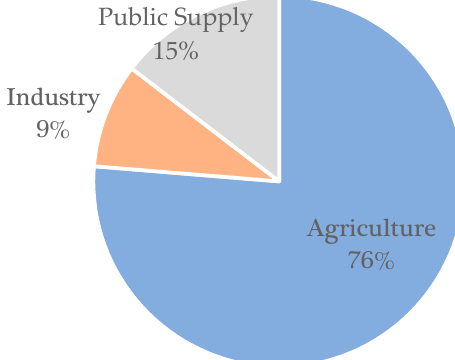
Figure 1. Percentage of Water Use in Agriculture, Industry and Public Supply, 2016. Source: Authors’ elaboration using data from CONAGUA [22], 2016.